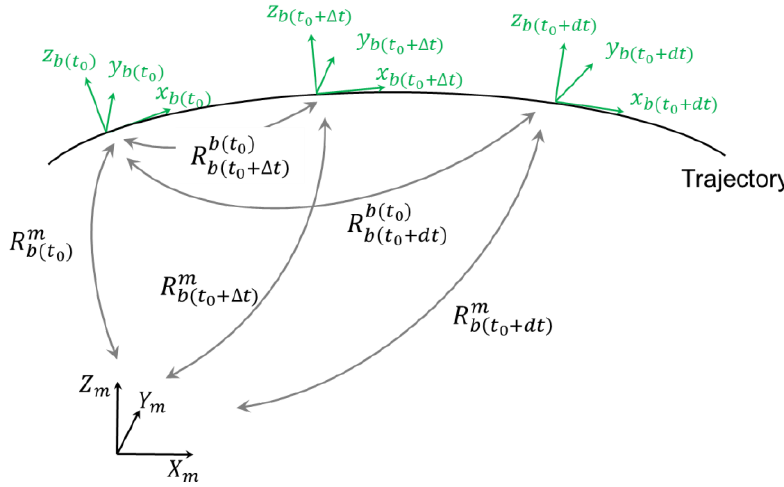
Figure 4. Establishing an expression for the correct IMU body frame orientation in the presence of time delay.